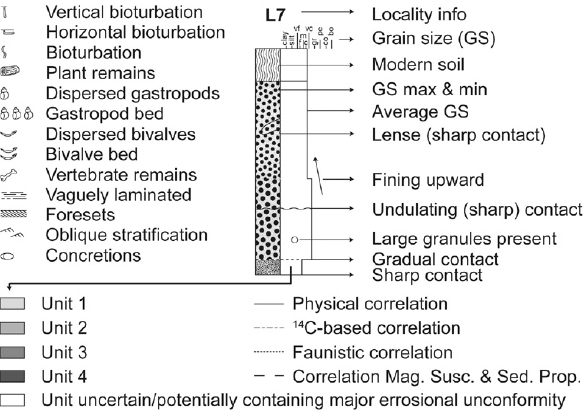
Fig. 3. Legend to the symbols and the diverse types of correlations between profiles used in Figs. 4 and